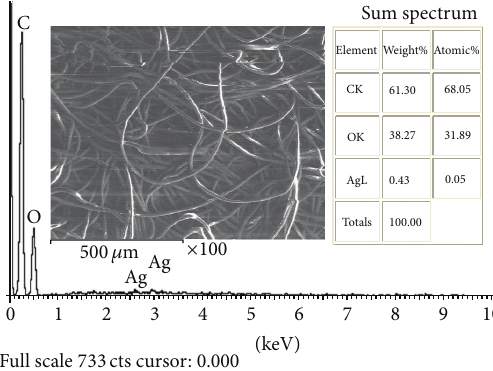
Figure 5: SEM-EDX micrograph with Au layer for fabric after nAg 2 O